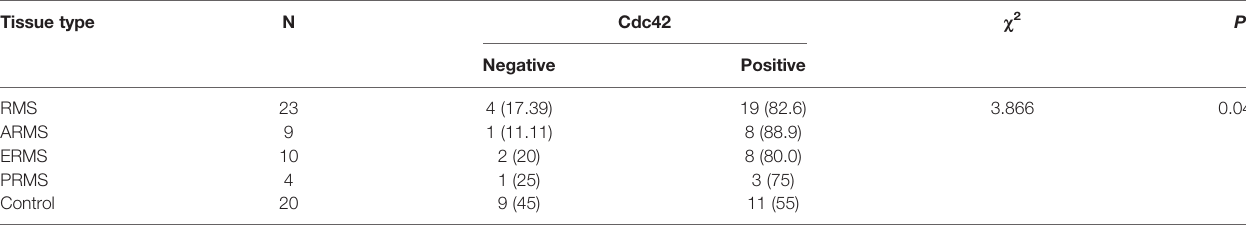
TABLE 2 | Expression of Cdc42 protein in different types of RMS and normal muscle tissue. Tissue